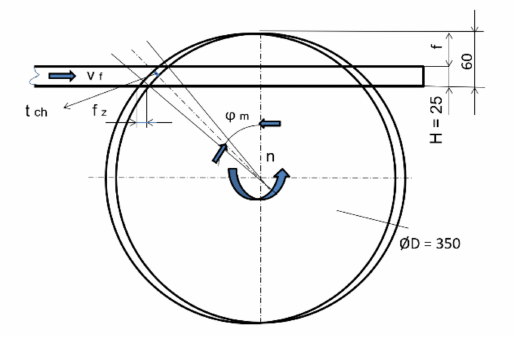
Figure 3. Representation of the mean chip thickness, cutting trajectory through the plate thickness, and kinematic